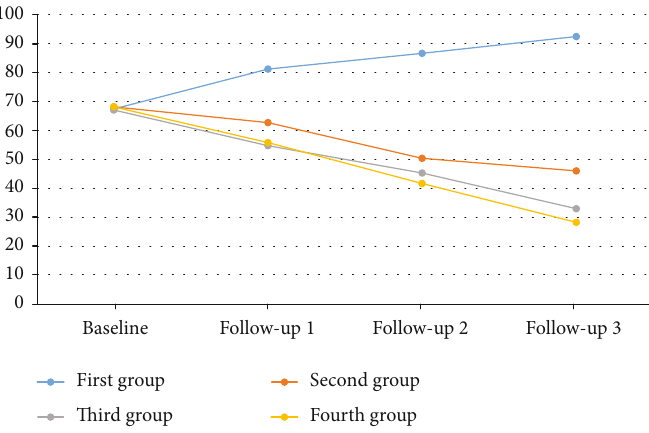
Figure 5: The trend of ICU working stress from baseline up to 21-month